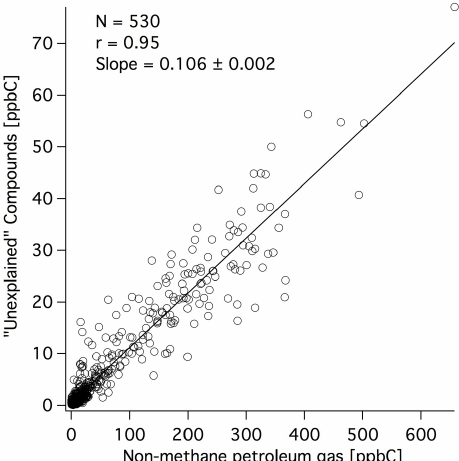
Figure 5. The sum of unexplained compounds was very well cor- related with gas-phase emissions from the modeled petroleum op- erations source with a slope of 0.106. This increases emissions by 10.6% from the original